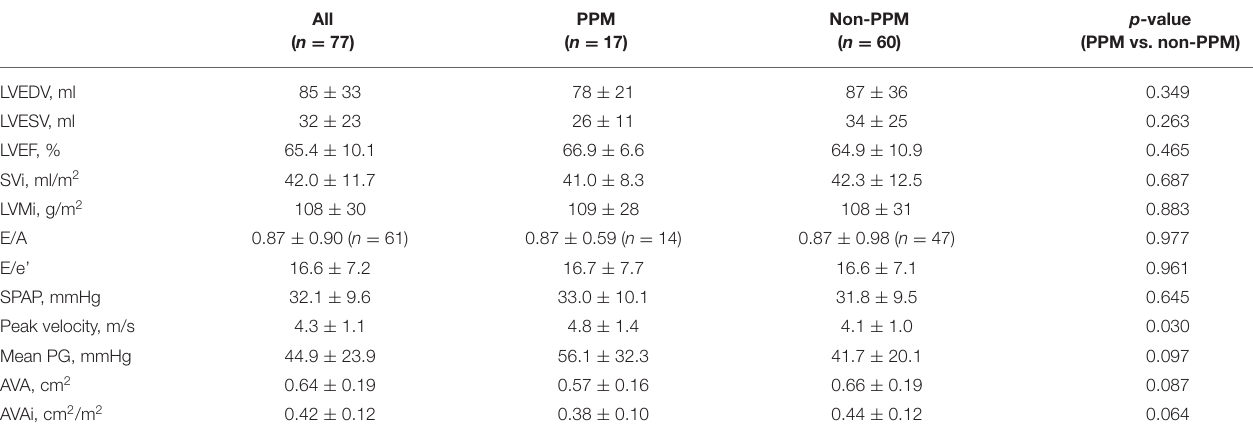
TABLE 2 | Preoperative echocardiography characteristics.